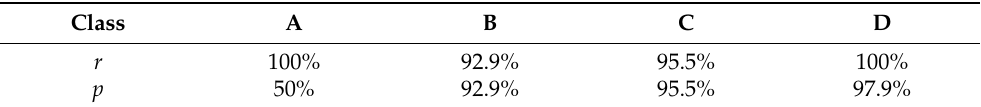
Table 6. The results of r and p for the